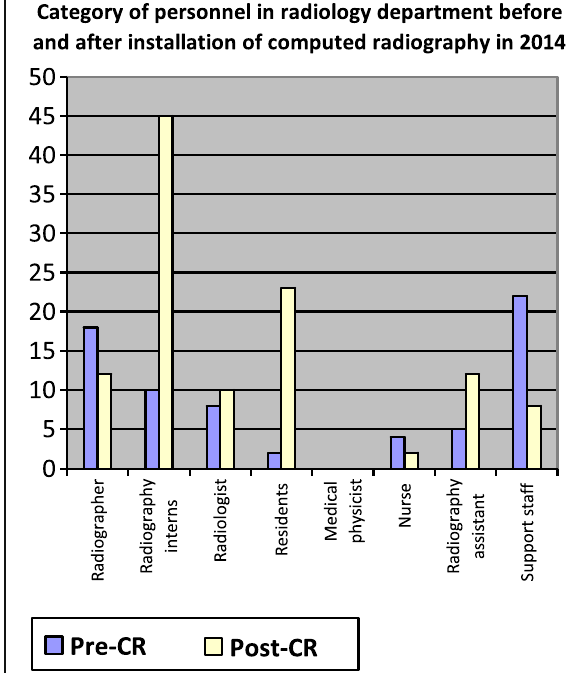
Fig. 4 Compound bar chart of categories of personnel found in the department